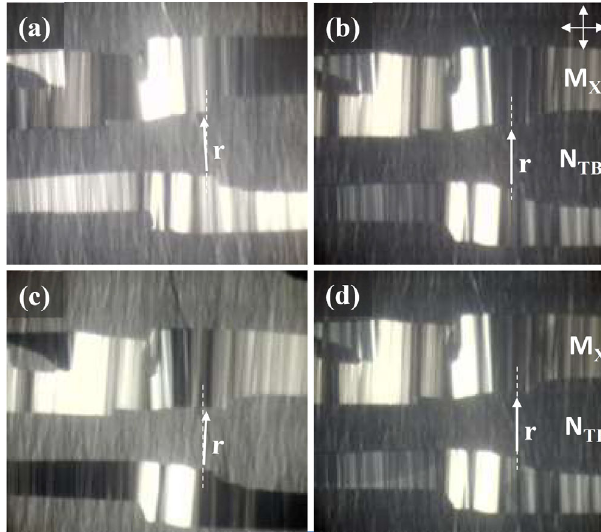
FIG. 22. Azimuthal alignment of the M domains coexisting X with the N phase at 101 . 8 °C. The sample is observed between TB crossed polarizers and rotated at angle ψ ¼ − 2 °, 0°, þ 2 °, and 0° in (a), (b), (c), and (d), respectively. Here, ψ is the angle between the rubbing direction r and the input polarizer. The slow axis N of the M regions is approximately parallel to r . The azimuthal X deviations of N from r , at angles typically smaller than (cid:4) 3 °, are due to slight disorientations of the smectic single domains of the M phase. The analysis of the transmitted light and the smectic X textures shows that N is vertical in the pictures, perpendicular to the smectic layers that are horizontal, which confirms the Sm A (and not Sm C ) nature of the M phase. In (d), an electric field, X larger than the threshold of the Fre´edericksz-like transition, is ¼ 7 V). applied to the sample ( f ¼ 6 kHz, U rms